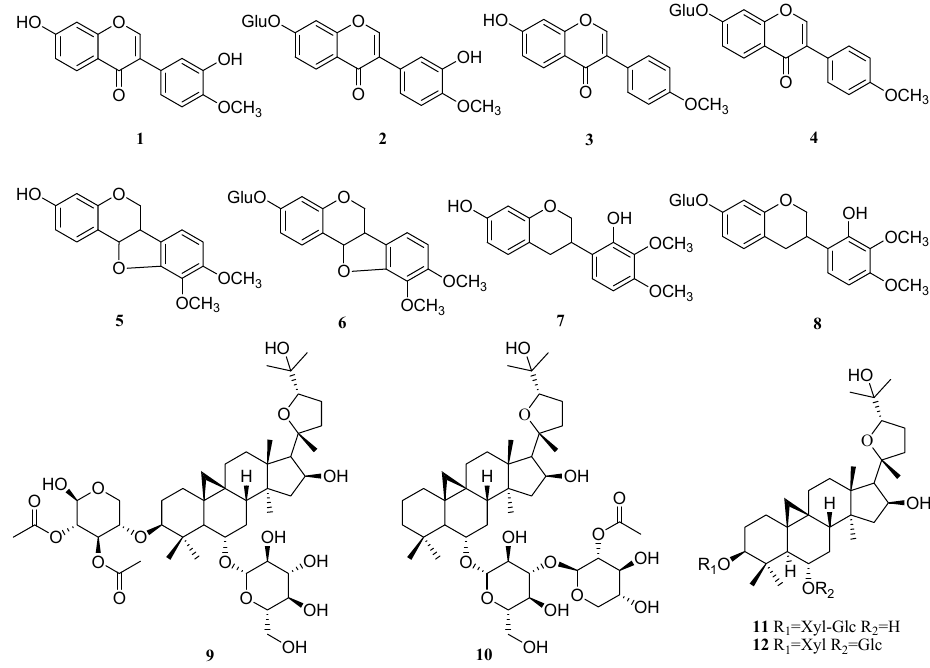
Figure 1. The structures of reference compounds 1 – 12 : Eight flavonoids: Calycosin ( 1 ), calycosin-7-glucoside ( 2 ), formononetin ( 3 ), ononin ( 4 ), methylnissolin ( 5 ), astraisoflavan-7- O - β - D -glucoside ( 6 ), 7,2 (cid:48) -dihydroxy-3 (cid:48) ,4 (cid:48) -dimethoxy-isoflavane ( 7 ), and 7,2 (cid:48) -dihydroxy-3 (cid:48) ,4 (cid:48) -dimethoxy isoflavan-7- O - β - D -glucopyranoside ( 8 ); and four tri-terpenoid saponins: Astragaloside I ( 9 ), astragaloside II ( 10 ), astragaloside III ( 11 ), and astragaloside IV ( 12